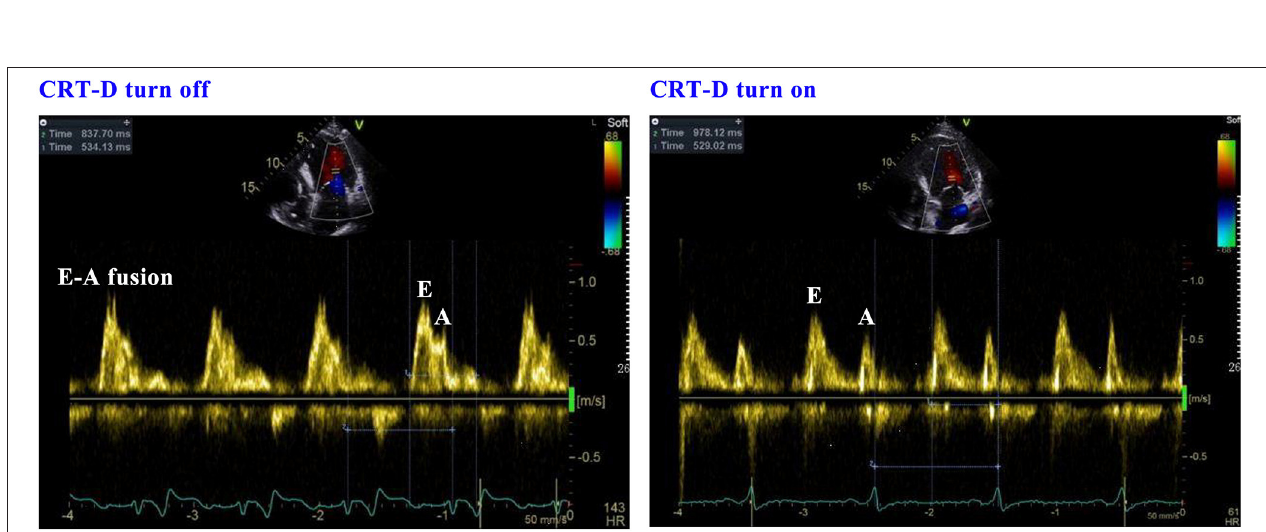
FIGURE 5 | The response of echocardiography when the CRT-D is turned on and off. CRT-D, cardiac resynchronization therapy with defibrillation.